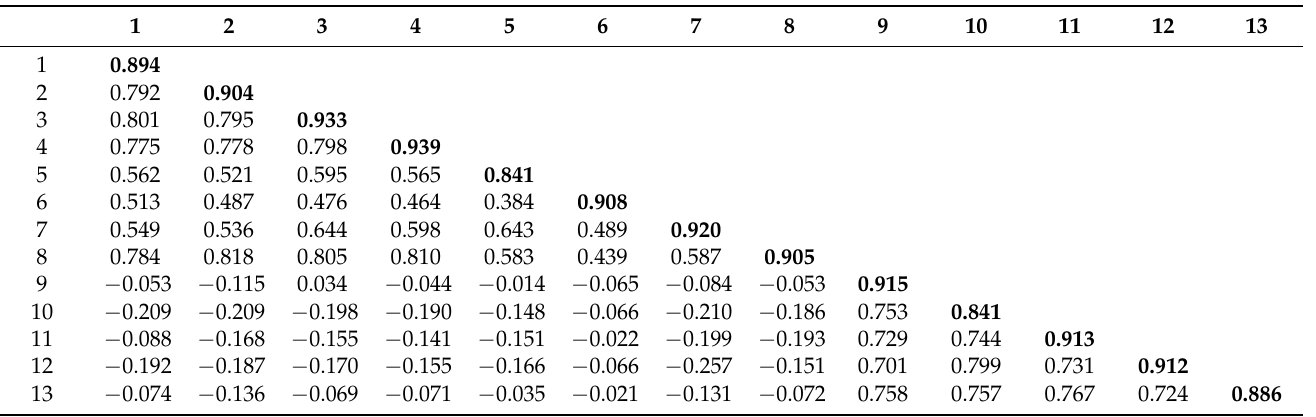
Table 2. Correlation matrix of potential constructs of measurement